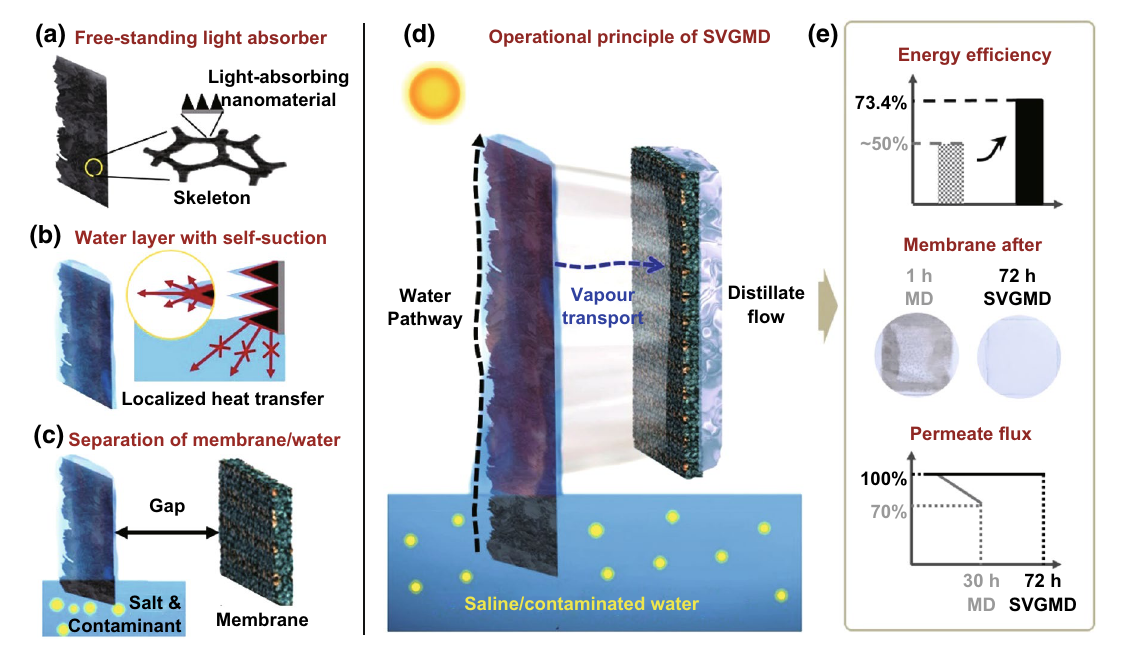
Fig. 1 Solar vapour gap membrane distillation (SVGMD): enabling concept, key features, and operational principle. a–c Summary of the key features: a free-standing light absorber consisting interconnected skeleton and light-absorbing nanomaterials; b formation of thin water layer with self-suction and localized heating. c Solar vapour in the gap which separates the membrane from the water. d Schematic of SVGMD. Supe- rhydrophilic light absorber ensures fast water suction. Under solar illumination, localized heat transfer leads to the efficient generation of solar vapour in the gap, which passes through the membrane and condenses with the distillate flow. e The SVGMD concept and scalable water purifi- cation system with high solar-water energy efficiency, excellent anti-fouling performance, and stable permeate